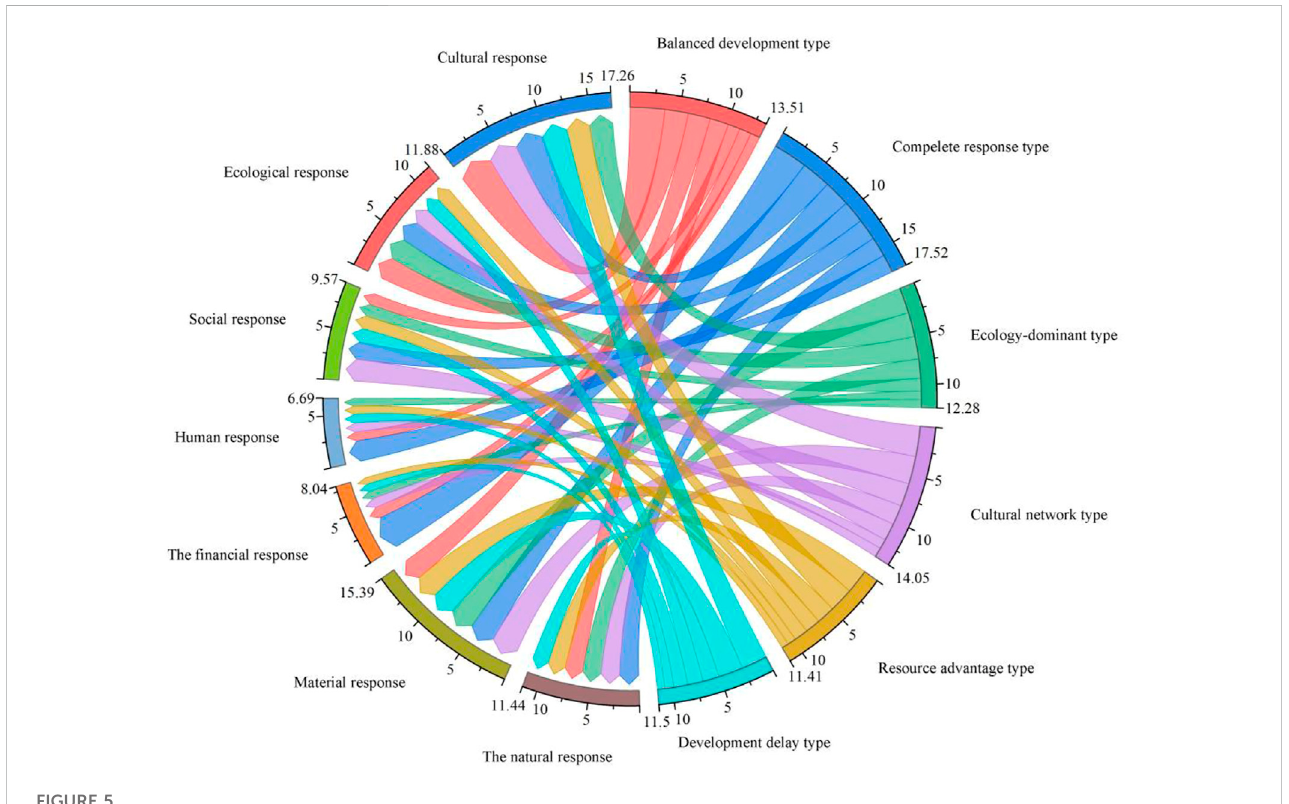
FIGURE 5 Degree of responsiveness of different response